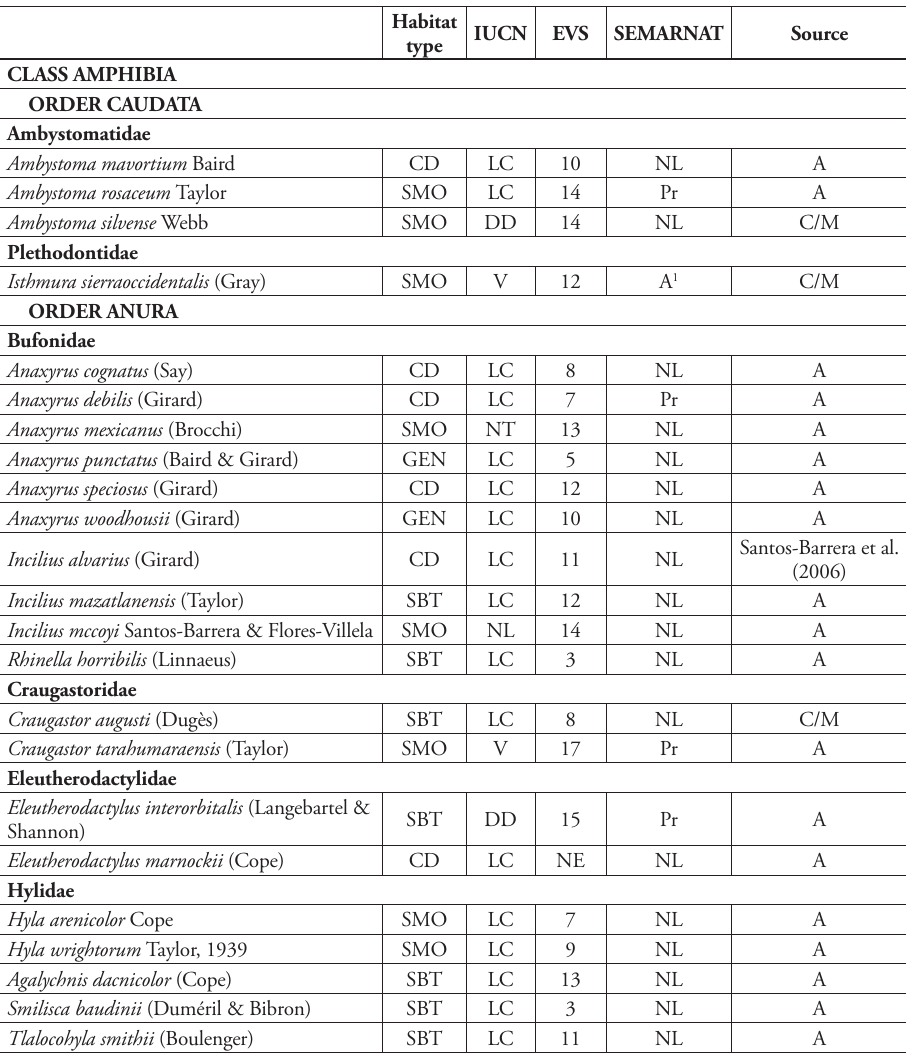
Table 1. Checklist of amphibians and reptiles of Chihuahua providing the habitat type (CD = Chi- huahuan Desert, SMO = Temperate Forests of the Sierra Madre Occidental, SBT = Subtropics – Canyons of the Sierra Madre Occidental; GEN = Generalist – occupies more than one habitat type), IUCN Status (DD = Data Deficient; LC = Least Concern, V = Vulnerable, NT = Neat Threatened; E = Endangered; CE = Critically Endangered) according to the IUCN Red List (The IUCN Red List of Threatened Spe- cies, Version 2016.1; www.iucnredlist.org; accessed 30 June 2016), Environmental Vulnerability Score (EVS; the higher the score the greater the vulnerability; NE = not evaluated) from Wilson et al. (2013a,b) and Johnson et al. (2015a), and conservation status in Mexico according to SEMARNAT (2010) (P = in danger of extinction, A = threatened; Pr = subject to special protection, NL – not listed). Source denotes whether the species was observed in the field by the authors (A), documented in the CONABIO data base and/or museum collections (C/M), or found in the literature (citation of